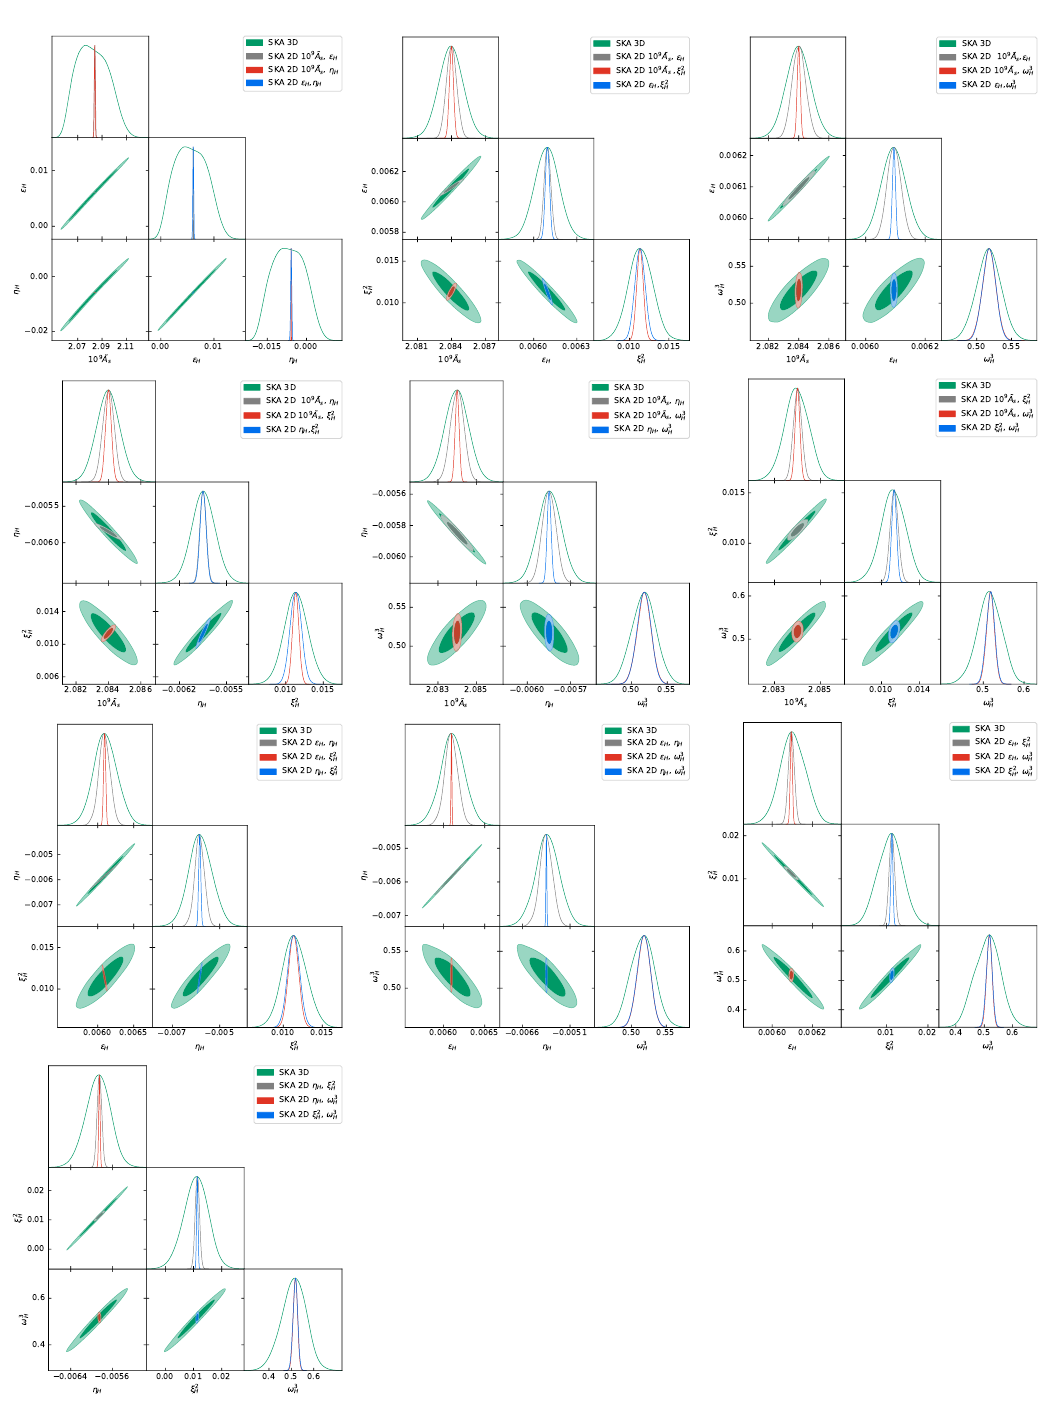
Figure 6: Marginalized 3-dimensional likelihoods from Fig. 5, compared with the 2-dimensional likelihoods in Fig.